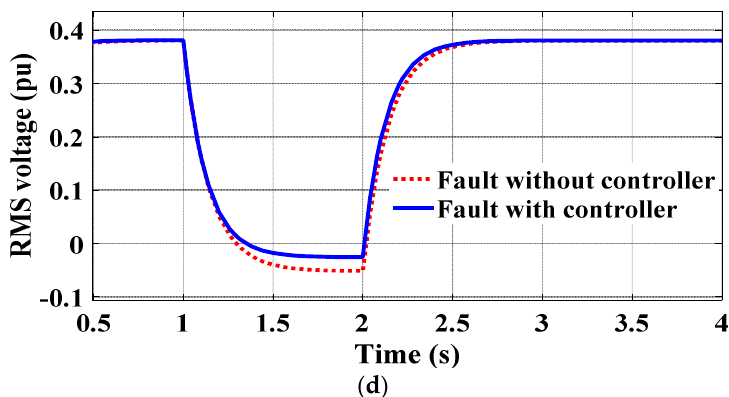
Figure 4. ( a ) Symmetrical fault current of the stator; ( b ) magnified view of the stator fault current controller; ( c ) stator faults current with and without a controller; ( d ) comparison of the RMS voltage and current with and without a controller.